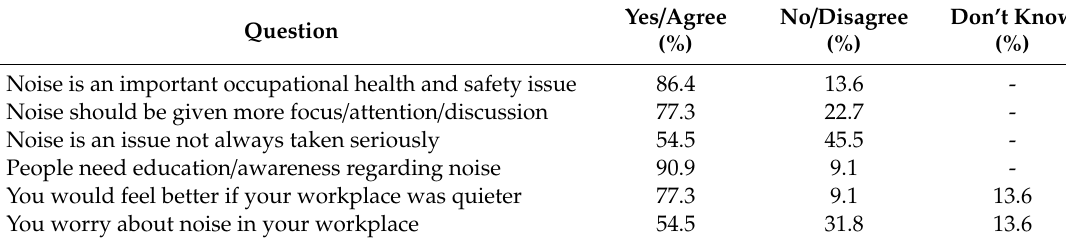
Table 2. Attitudes of workers regarding occupational noise. (N =